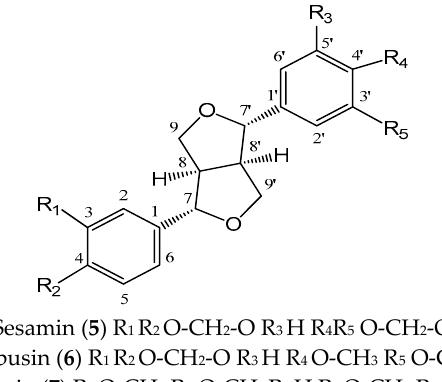
Figure 1. Major compounds isolated from Castilleja tenuiflora methanolic extract.